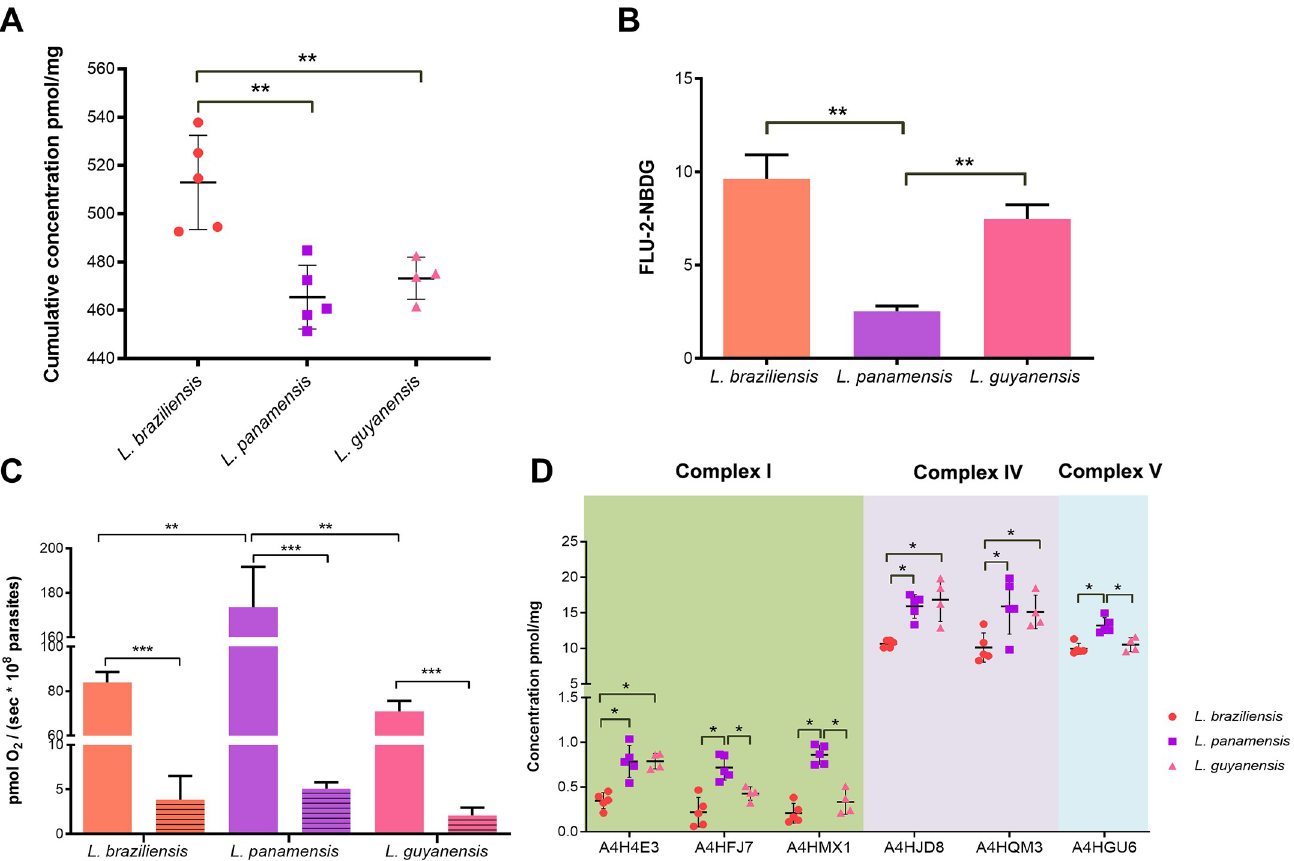
Fig 4. Leishmania ( Viannia ) species significantly differ in the abundance of energy metabolism enzymes. (A) Cumulative concentration of the proteins involved in glycolysis. Each symbol (dots, squares or triangles) show the total sum of the concentration values of proteins involved in glycolysis in each of the 5 biological replicates for L . braziliensis and L . panamensis or 4 biological replicates for L . guyanensis . Statistical differences by t test (p < 0.003 Lb x Lp; p < 0.006 Lb x Lg). (B) 2-NBDG uptake levels. Promastigotes were incubated with 300 μ M 2-NBDG, a fluorescent glucose analogue, and further analysed by flow cytometry. Bars show mean ± SD of at least three independent experiments. Statistical differences by t test (p < 0.001). (C) Oxygen consumption under routine conditions (open bars) or in the presence of 2 μ M antimycin A (residual oxygen consumption-ROX, filled bars). ROX control shows a reduction up to 95% in mitochondrial functionality. Bars show mean and standard deviations of at least three independent experiments. Significant differences by t test. �� p < 0.001; ��� p < 0.0001. (D) Concentrations of specific proteins involved in oxidative phosphorylation. Complex I (green background), complex IV (purple background) and complex V (blue background) enzymes are identified with the UniProt code (S4 Table). Values represent mean ± SD of protein concentration (pmol/mg) [n = 5 biological replicates for L . braziliensis (dots) and L . panamensis (squares) and n = 4 for L . guyanensis (triangles)]. � Statistical differences according to Perseus analysis (FDR < 0.01) and further analyzed by the Holm-Sidak method (p <